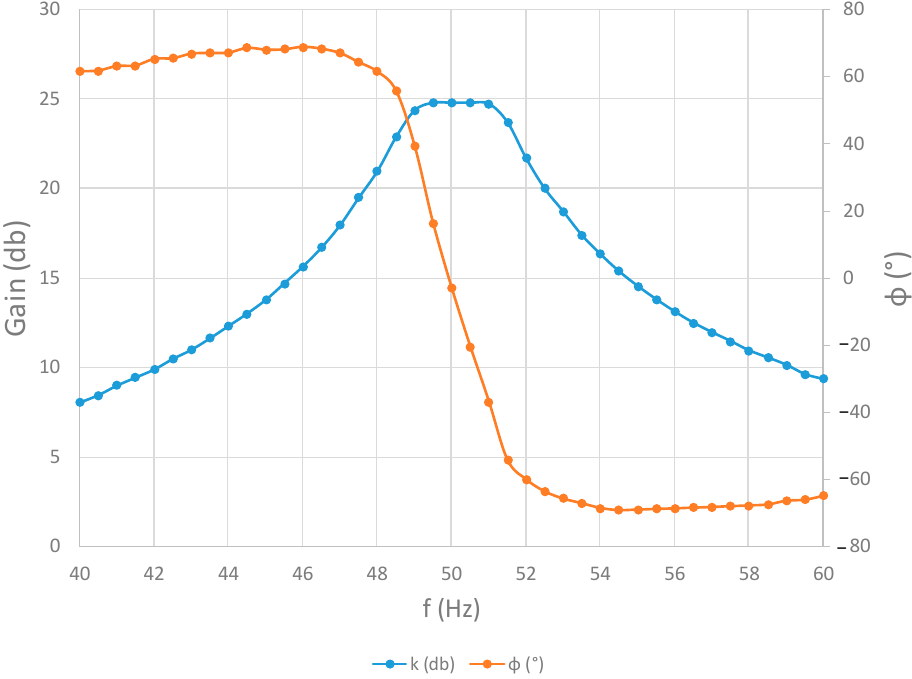
Figure 4. Bode plot of the proposed controller structure.